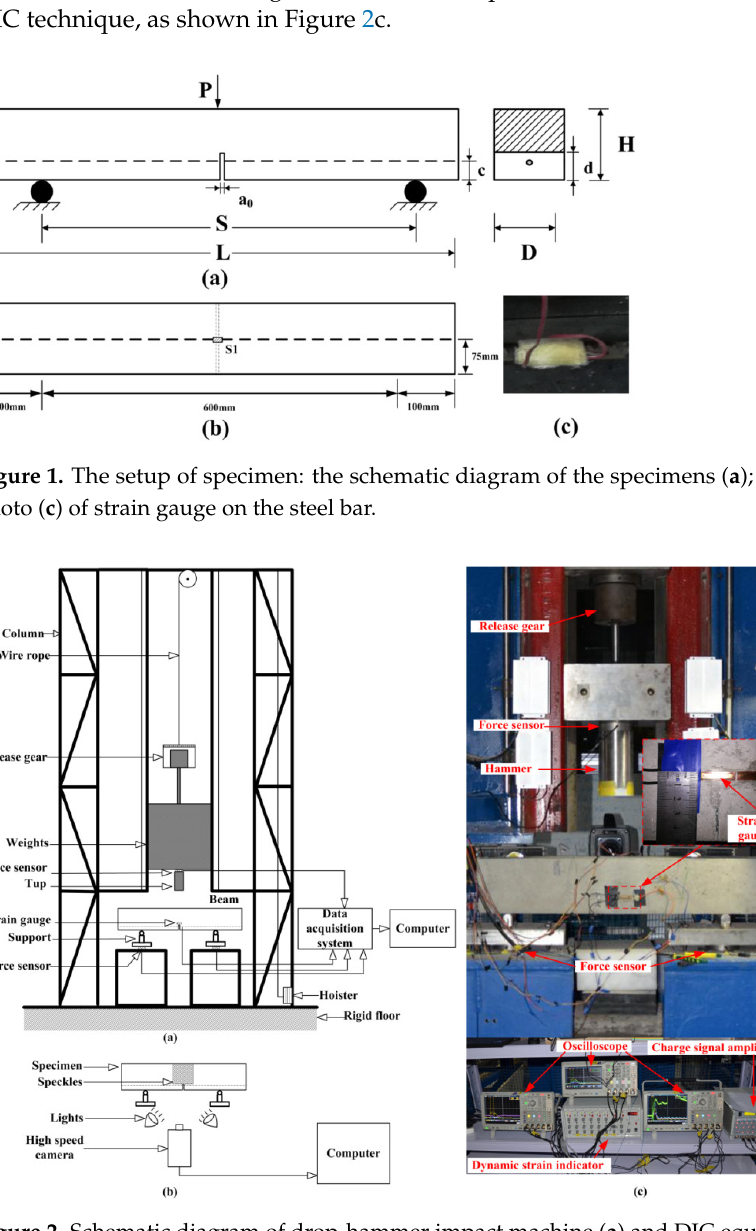
Figure 2. Schematic diagram of drop-hammer impact machine ( a ) and DIC equipment ( b ); photo of impact experiment setup ( c ).